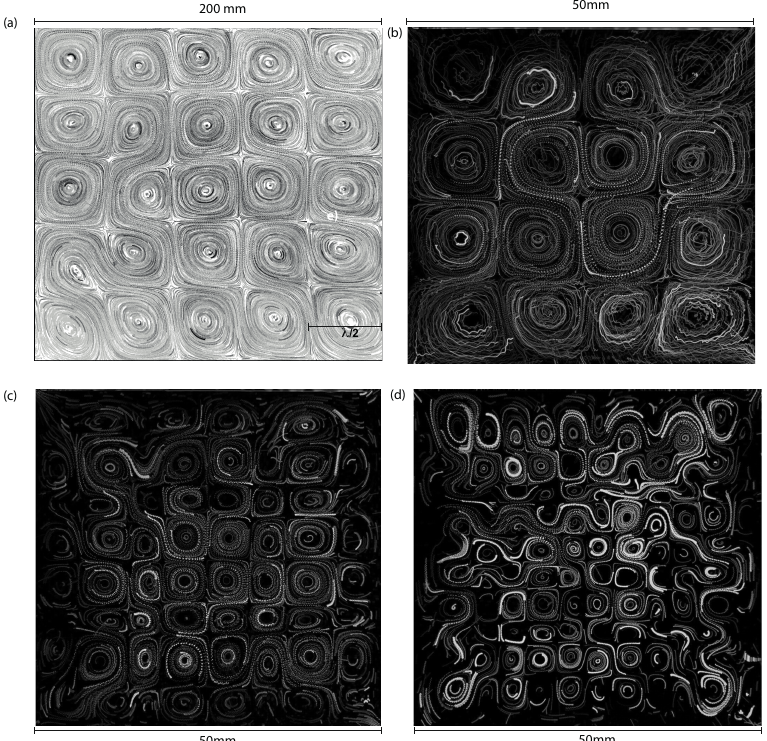
Figure 1. Particle trajectories tracked on the water surface at the relative phase shift between two orthogonal standing waves of π /2. ( a ) 300 mm container, f = 4.58 Hz, water depth h = 80 mm. In the 50 mm container, lattices are generated at ( b ) f = 9.4 Hz, ( c ) f = 16.4Hz, and ( d ) f = 26 Hz. The water depth in the 50 mm container is h =15 mm. The corresponding wavelengths of the standing waves are λ = 80, 25, 12.5, and 8